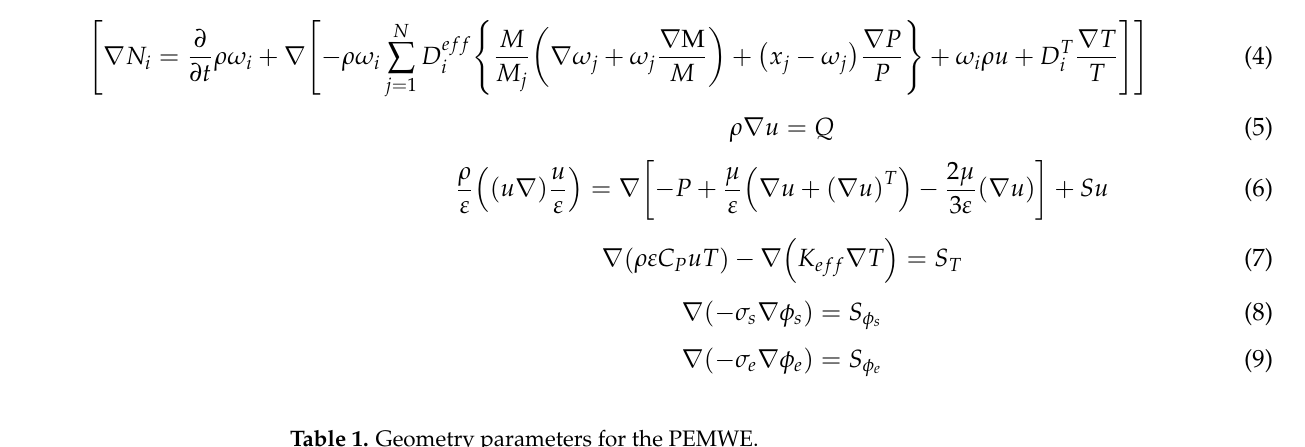
Table 1. Geometry parameters for the PEMWE.